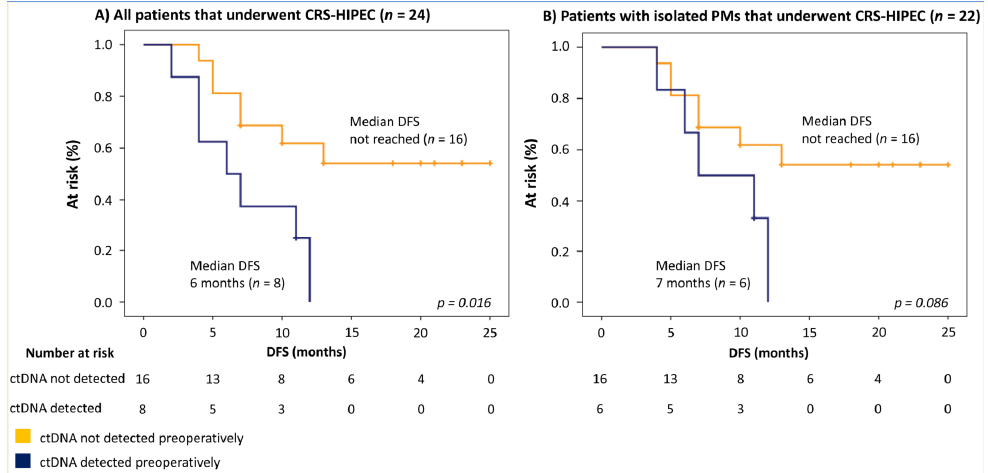
Figure 3. Survival analysis of patients who received CRS-HIPEC. ( A ) All patients ( n = 24). ( B ) All patients except those diagnosed with preoperative liver metastases ( n = 22). DFS: Disease-free Survival.